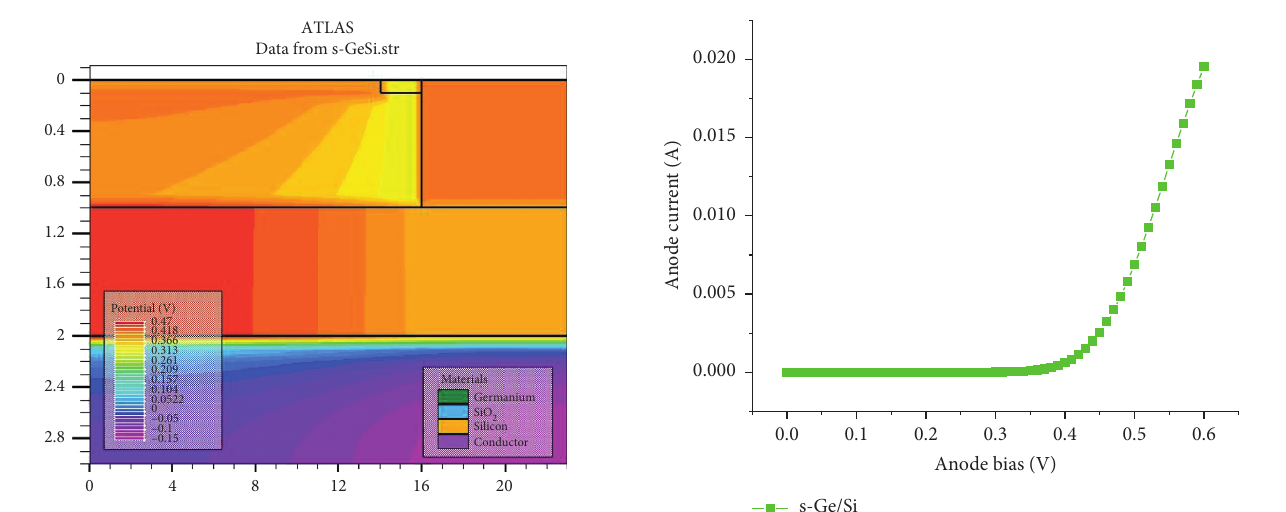
Figure 6: Extension Ge Schottky diode potential distribution on a Si substrate.